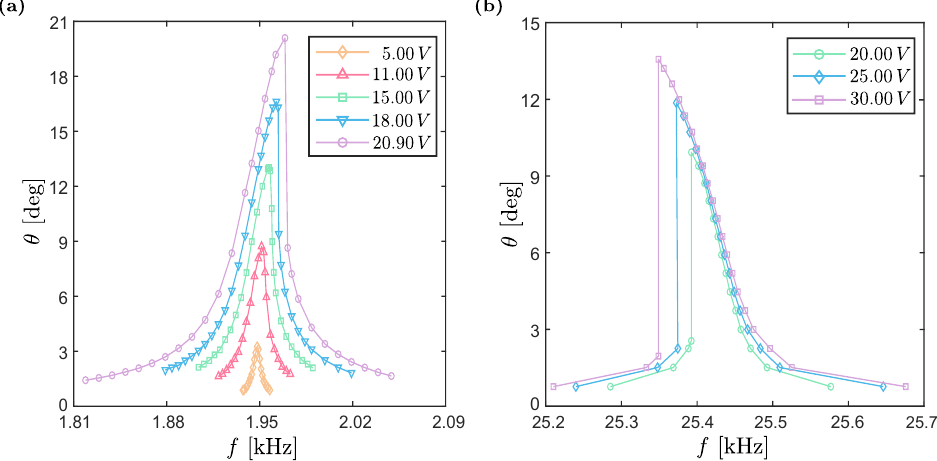
Figure 3. Experimental FRCs for Micromirror 1 ( a ) and Micromirror 2 ( b ). Each marker represents a different experiment where the frequency of the device is fixed and the maximum opening angle is